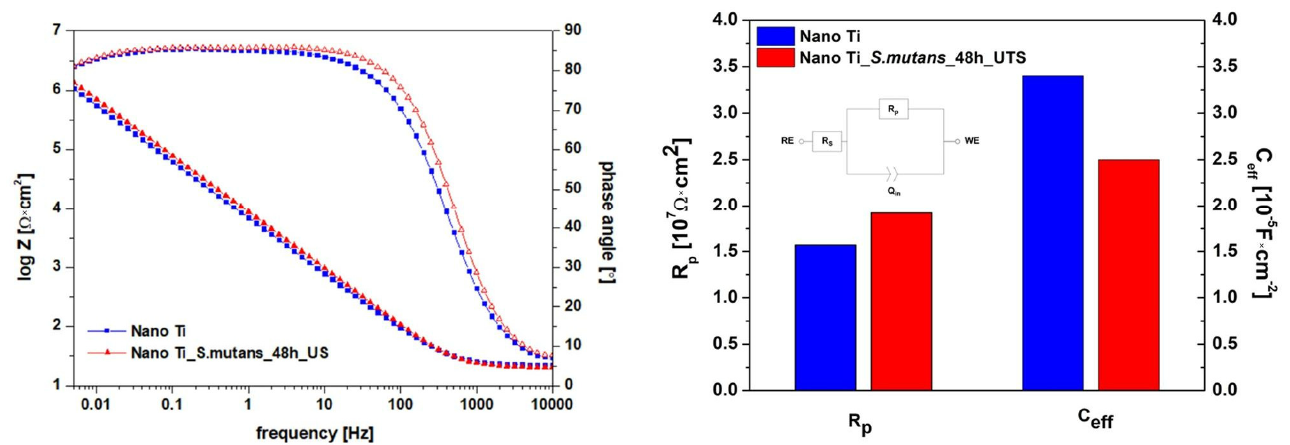
Figure 6. Corrosion resistance of nanostructured Ti in the polished state and after bacteria removal (electrochemical evaluation, EIS tests).